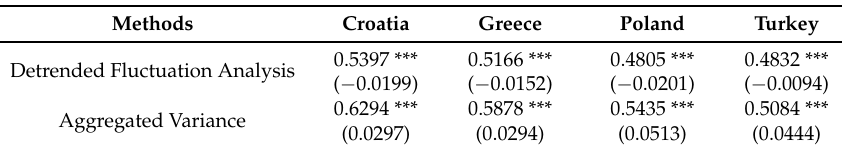
Table 3. Monofractal H statistics for the original series.